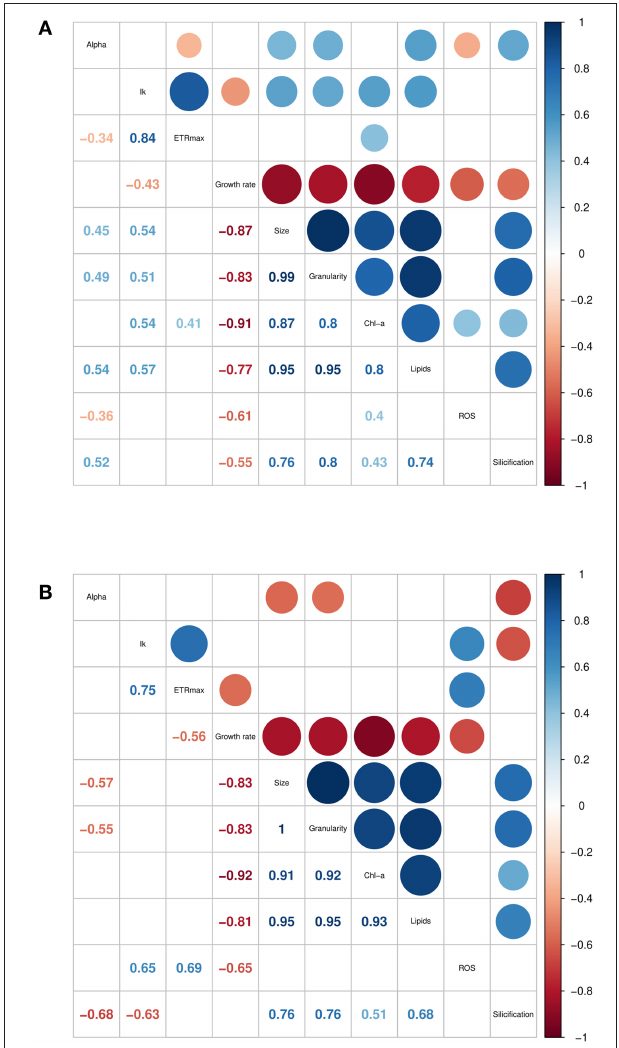
FIGURE 3 | Correlation matrices of trait data collected for six Thalassiosira strains, grown in (A) multiwell plates, and (B) 50mL tissue culture flasks. Only significant ( p < 0.05) correlation coefficients are shown. Trait units are found in Supplementary Table 1